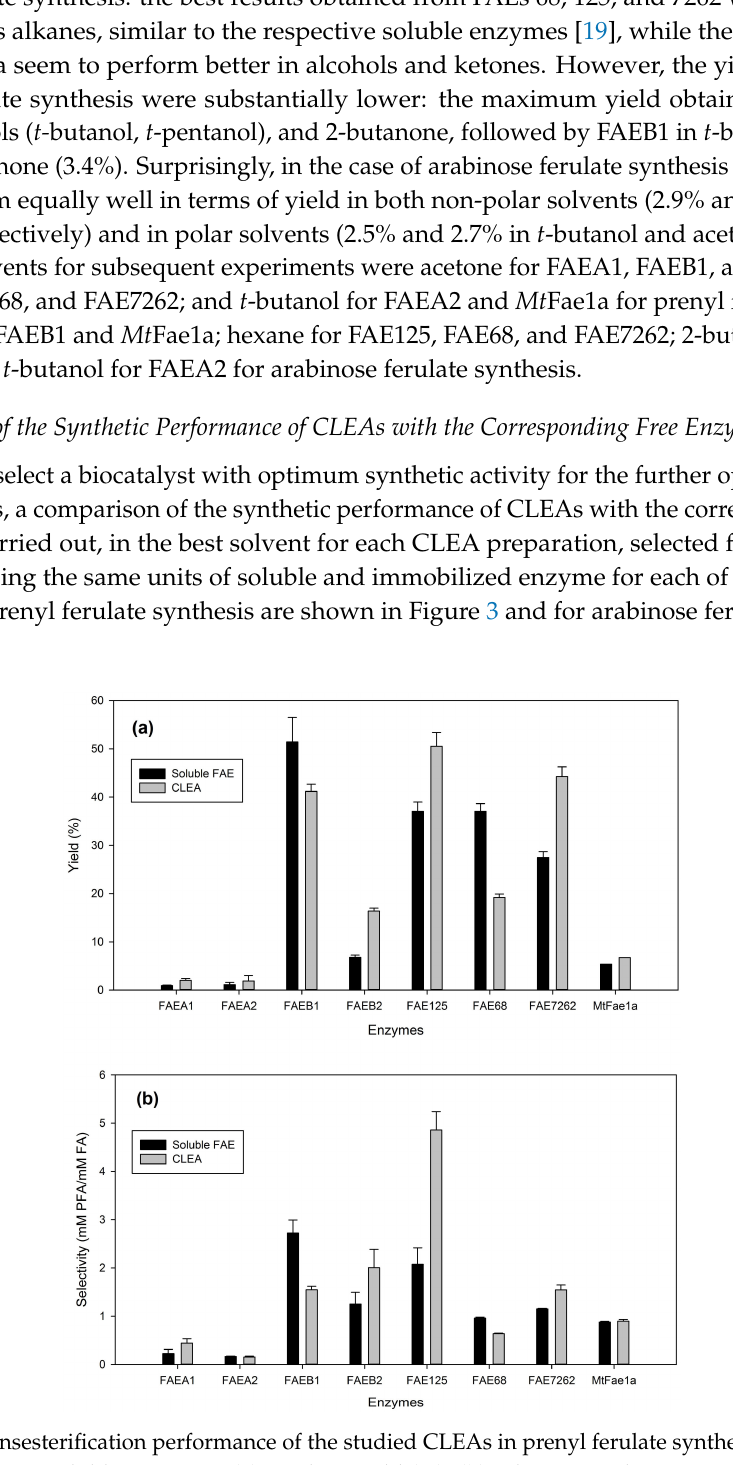
Figure 3. Transesterification performance of the studied CLEAs in prenyl ferulate synthesis, compared to the respective soluble enzymes. ( a ) product yield (%), ( b ) selectivity. The same units of soluble enzymes and CLEAs have been added to each reaction. The reactions were performed in the optimum solvent for each CLEA preparation, as mentioned in Section